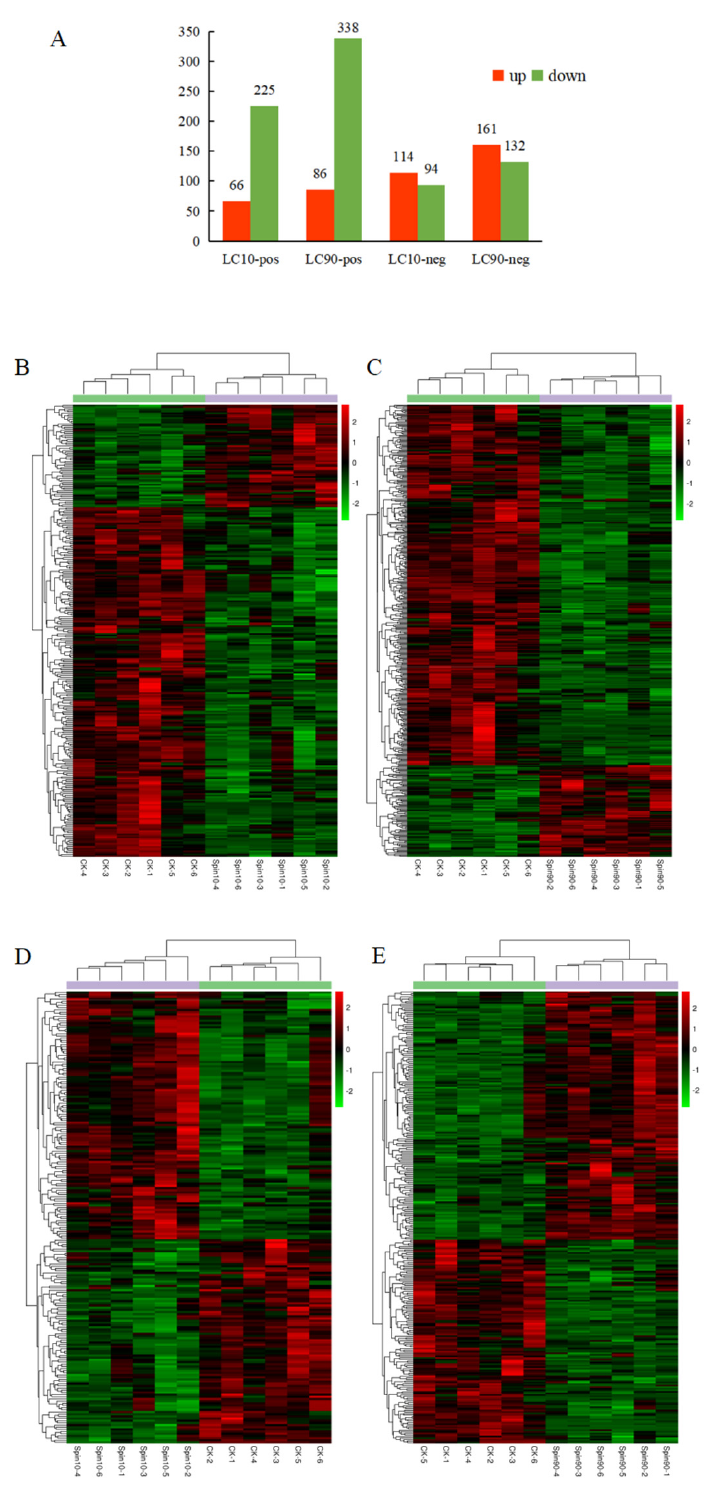
Figure 3. Analysis of differentially expressed (DE) metabolites in S. frugiperda to spinetoram stress. ( A ) Numbers of metabolites that were up-regulated (red) and down-regulated (green) in spinetoram-stressed fall armyworm larvae. ( B – E ) Heatmaps of DE metabolites in fall armyworm at pos-mode ( B , C ) and neg-mode ( D , E ) after spinetoram stress. Each column represents one sample, and each row represents one DE metabolite. Red color represents the relative level of the up-regulated metabolites, and green color represents down-regulation Metabolic pathway analysis.